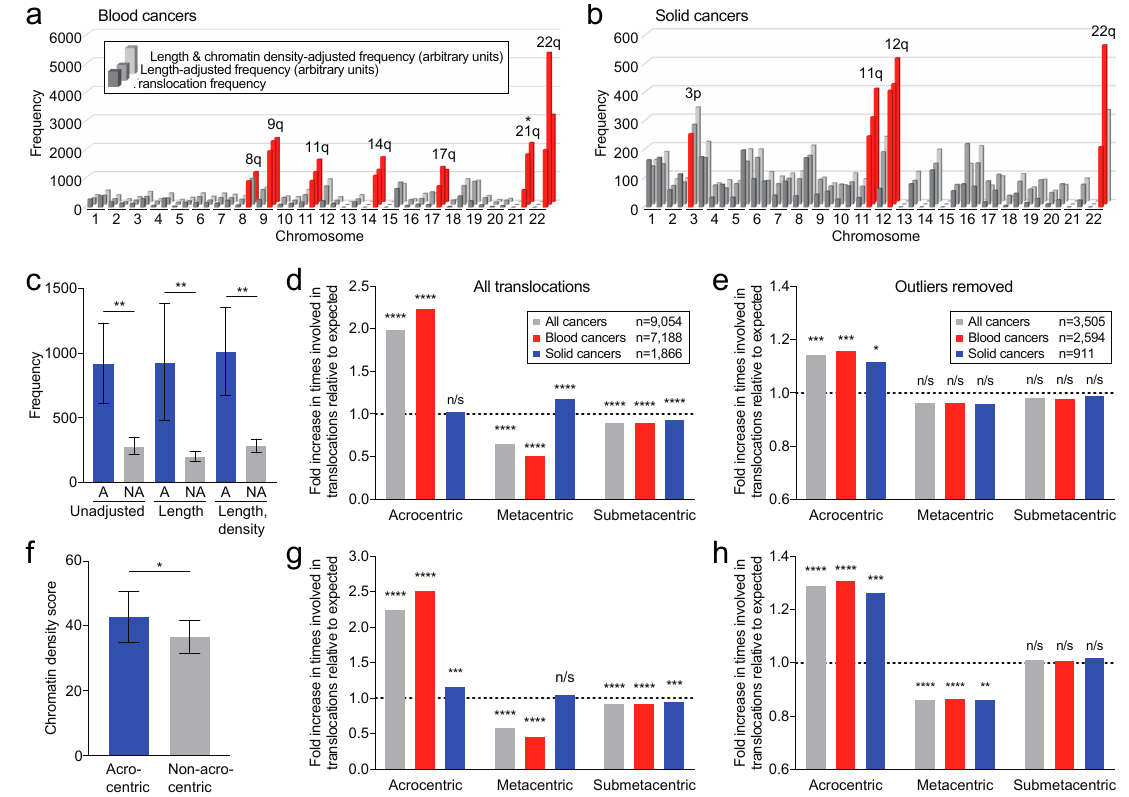
Figure 5. Translocation breakpoints preferentially occur in acrocentric chromosomes. ( a ) Bar graph showing the frequencies of translocation breakpoints per chromosome arm in blood cancers. From the front to the back, respectively, bars show translocation frequencies, chromosome arm length-adjusted frequencies (arbitrary units) and frequencies adjusted for both chromosome arm length and chromatin density (arbitrary units). Bars in red highlight statistically significantly increased frequencies compared to the frequencies of all chromosome arms. After removal of outlier translocations, only the frequency of chromosome arm 21q remains statistically significantly increased (*). ( b ) Bar graph as in ( a ) for solid cancers. No chromosome arm remains statistically significantly more frequently involved in translocations after removal of outlier translocations. ( c ) Bar graph showing that acrocentric chromosome arms (A) are significantly more often involved in translocations than non-acrocentric chromosome arms (NA), even after accounting for their physical length or physical length and chromatin density combined. p -values: Mann-Whitney U test. ( d ) Bar graph showing the fold increase in the observed involvement of chromosomes in translocations compared to the expected frequencies, which takes into account the length of the chromosomes. p -values: binomial test. ( e ) Bar graph as in ( d ) but with statistically identified outlier translocations removed. ( f ) Bar graph comparing chromatin densities of acrocentric and non-acrocentric chromosomes. p -value: t -test. ( g ) Bar graph as in ( d ) but with expected frequencies adjusted for different chromatin densities of the chromosomes. ( h ) Bar graph as in ( g ) but with statistically identified outlier translocations removed. N/s, not significant; *, p < 0.05; **, p < 0.01; ***, p < 0.001; ****, p < 0.0001.